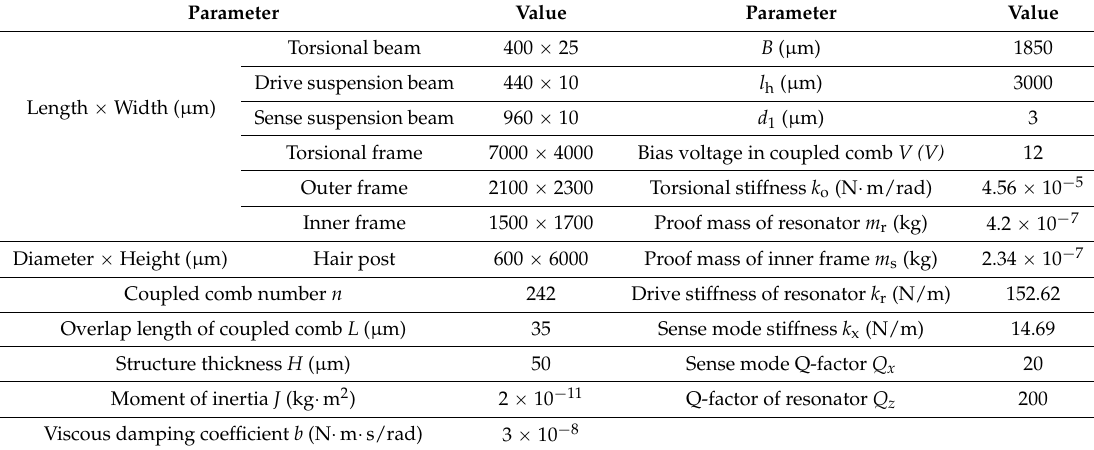
Table 1. Structure